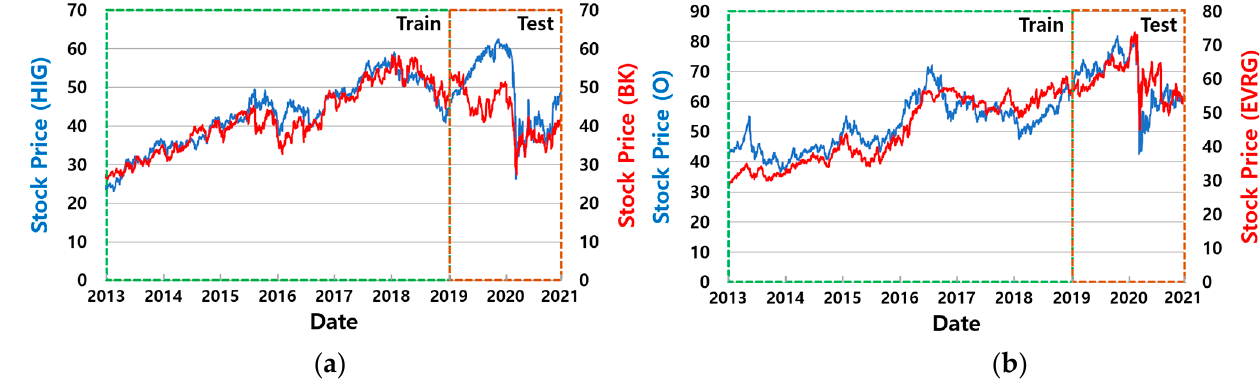
Figure 10. Stock pairs trending sideways. ( a ) HIG, BK. ( b ) O, EVRG.